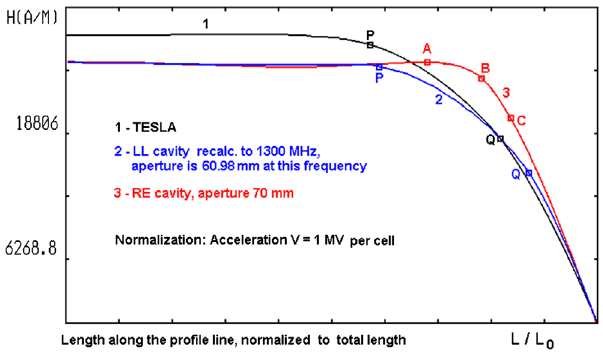
FIG. 4. Magnetic field on the surface of the cavities from Fig. 2.